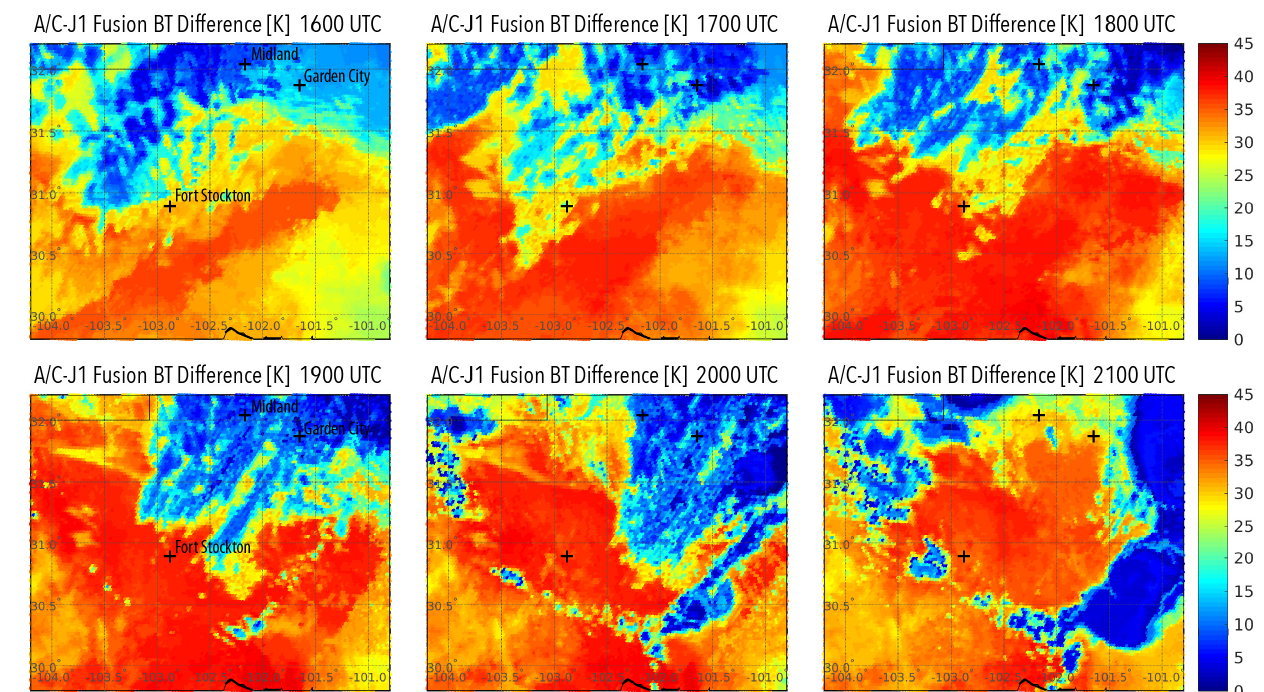
Figure 12. Hourly ABI/CrIS-J1 (A/C-J1) fusion results of the brightness temperature (BT) differences in [K] between CrIS channels at 786.25 cm − 1 and 784.38 cm − 1 , are shown from 1600 to 2100 UTC on 24 May 2022 (black crosses indicate locations of Midland, Garden City and Fort Stockton, TX).